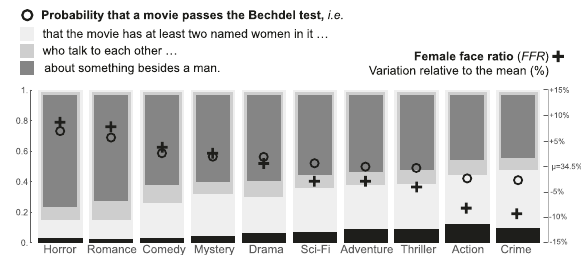
Fig. 3 Bechdel test and female face ratio ( FFR ) across a selection of popular movie genres. Each bar corresponds to a movie genre, fi lled with shadings representing the share of movies fi lling each criteria of the Bechdel Test. A circle indicates the share of movies passing the test while a cross indicates the variation to the mean with respect to the